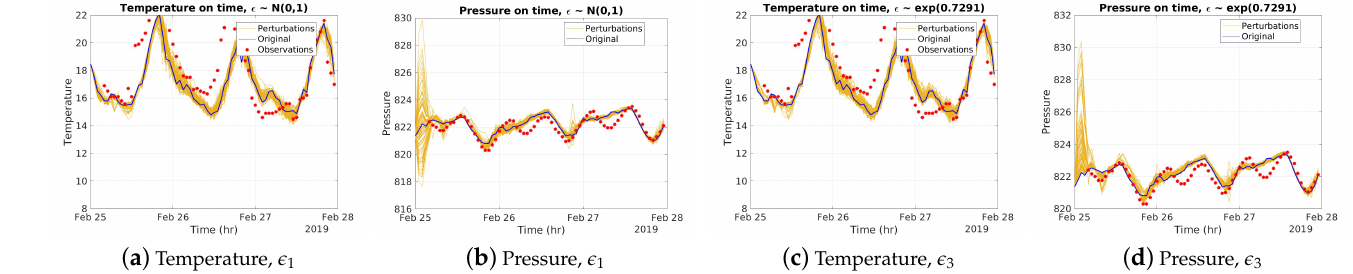
Figure 7. Representation of SIATA’s observations (red stars), the background (blue line series) and 100 perturbed realizations (yellow lines), using errors (cid:101) 1 and (cid:101) 3 , at AMVA station, for the variables surface temperature and pressure. ( a ) Temperature perturbed with (cid:101) 1 and background. ( b ) Pressure perturbed with (cid:101) 1 and background. ( c ) Temperature perturbed with (cid:101) 3 and background. ( d ) Pressure perturbed with (cid:101) 3 and